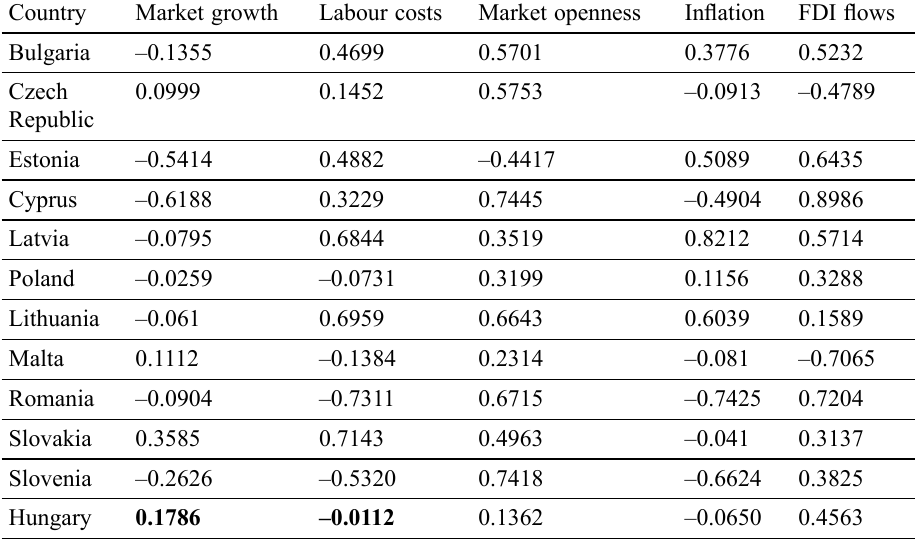
Table 2. The Estimation of Relationship between Independent Variables and FDI Intensity